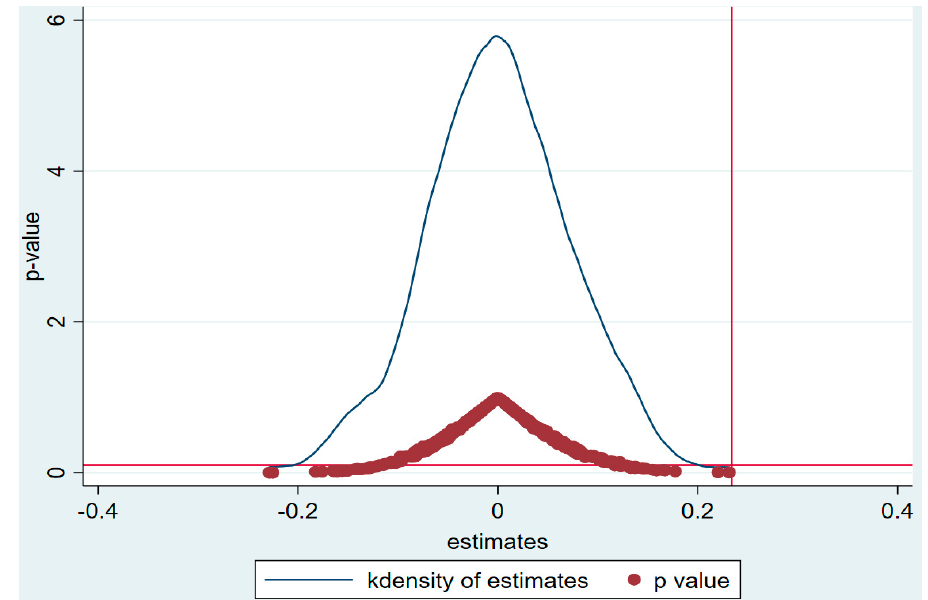
Figure 3. Result of placebo test.